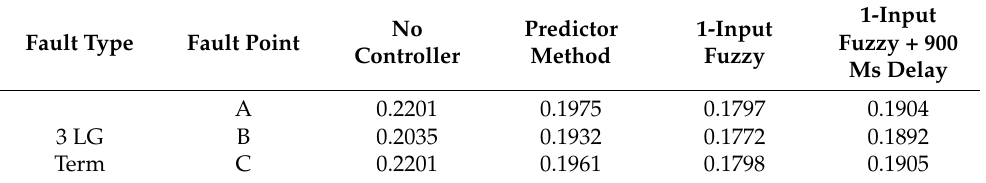
Figure 15. 3LG temporary faulty PCC voltage at location B. Table 4. Voltage indices.